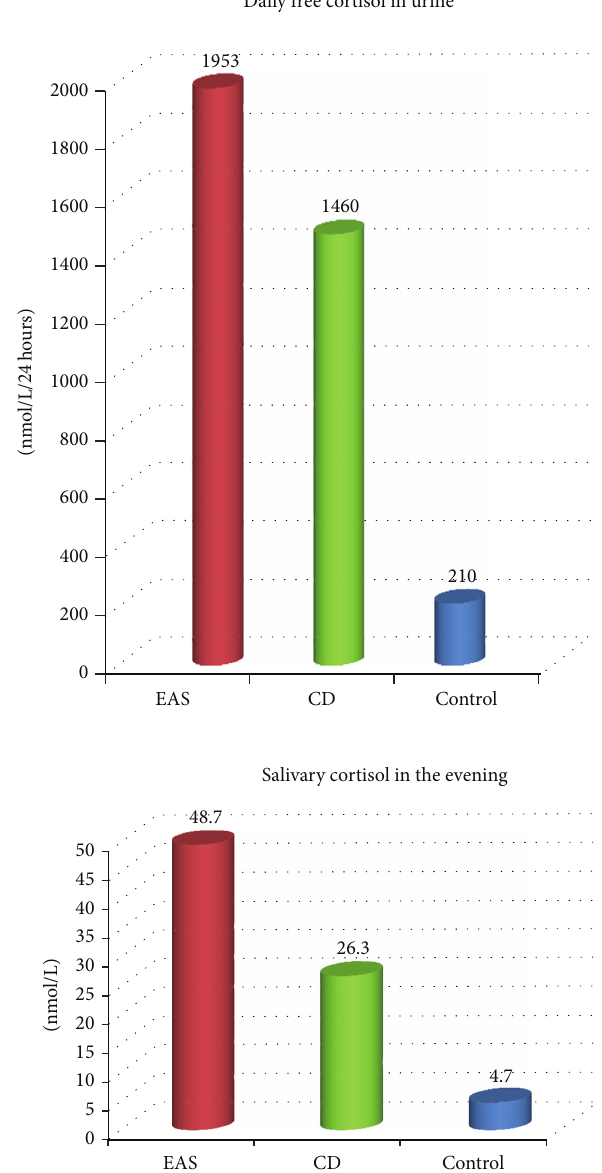
Figure 2: Free cortisol levels in 24-hr urine and saliva (measured at 23.00) in patients with Cushing’s disease and ectopic ACTH secretion compared with